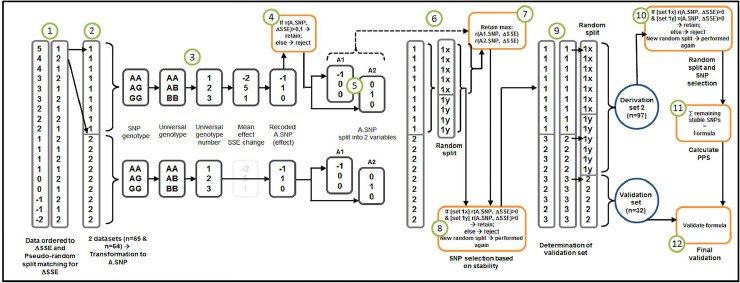
Visualization of recoding method.